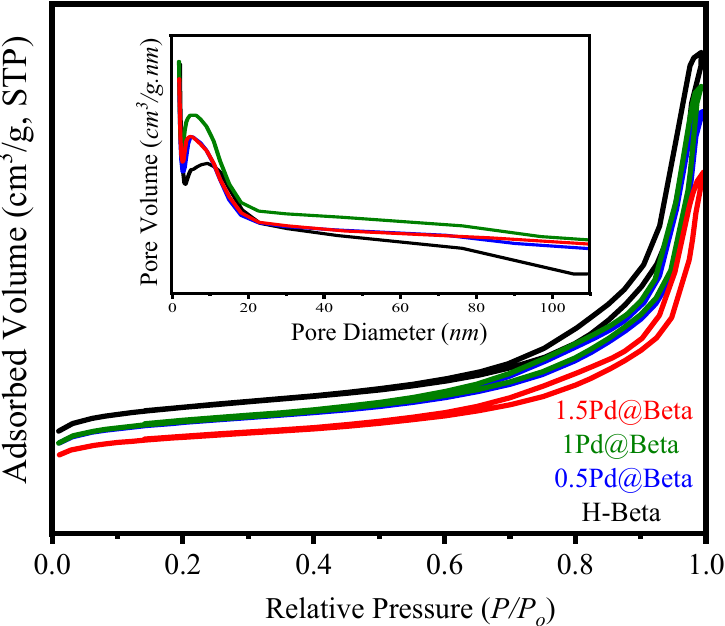
Figure 2. N 2 adsorption-desorption isotherms of the H-Beta, 0.5Pd@Beta, 1Pd@Beta, and 1.5Pd@Beta. The pore size distribution is given in the inset.